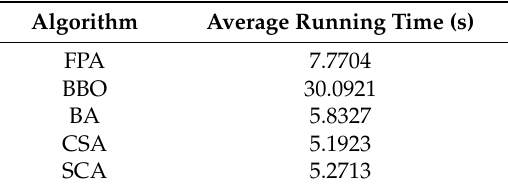
Table 4. Execution time of optimization